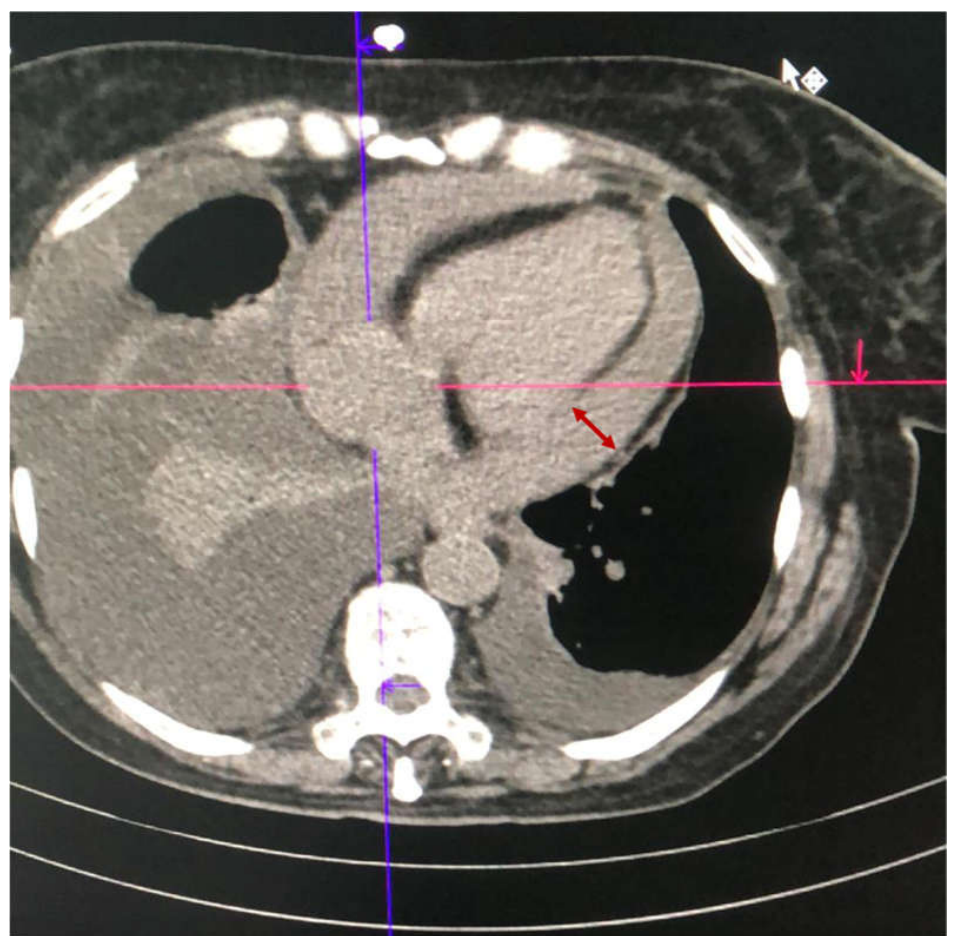
Figure 1. Thoracic CT-scan showing pericardial effusion ( Case 1 )